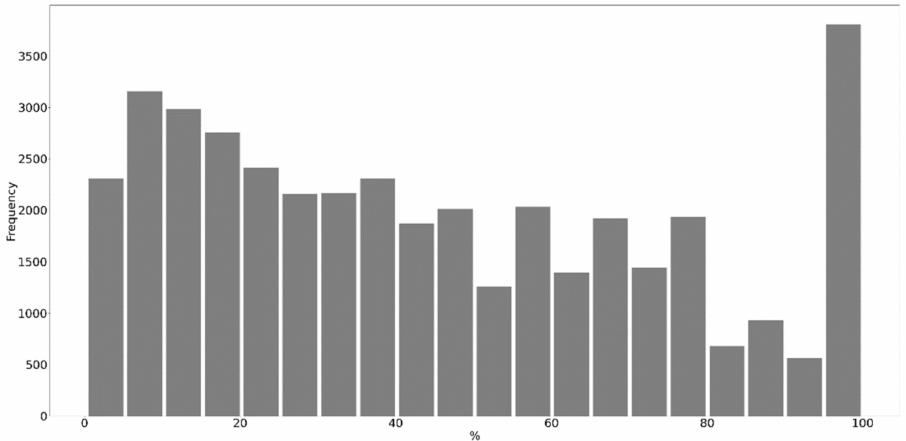
Figure 12. Distribution of of black locust coverage in small woody features (absences of black locust in SWF, e.g., 0% proportions were omitted for better visualizations; they represent 201,812